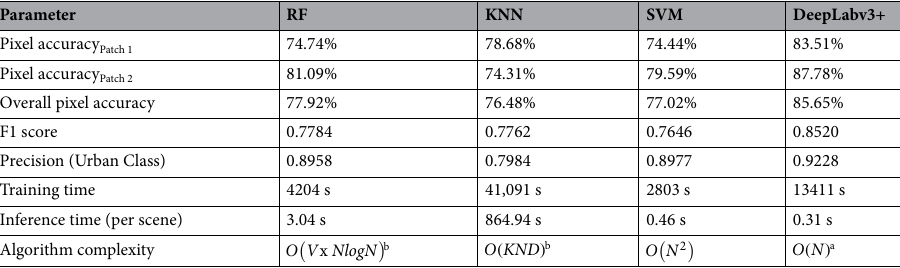
Table 1. The results of performance evaluation of traditional machine learning algorithms and DeepLabv3+ algorithm. a It is considered only the impact of the training set of size N, however, there are other factors (number of features, dimensionality, etc.) that can also affect the algorithm’s time complexity 42,92 . b In RF, the variable V = (ntree x mtry), where ‘ntree’ is the number of trees to build and ‘mtry’ represents how many variables need to sample at each node 28 . In KNN, ‘D’ is the distance between the training set observation and new observation, and ‘K’ represents the number of neighbors 27 . The variable ‘N’ represents the number of training set size used in SVM 29 and other listed algorithms.